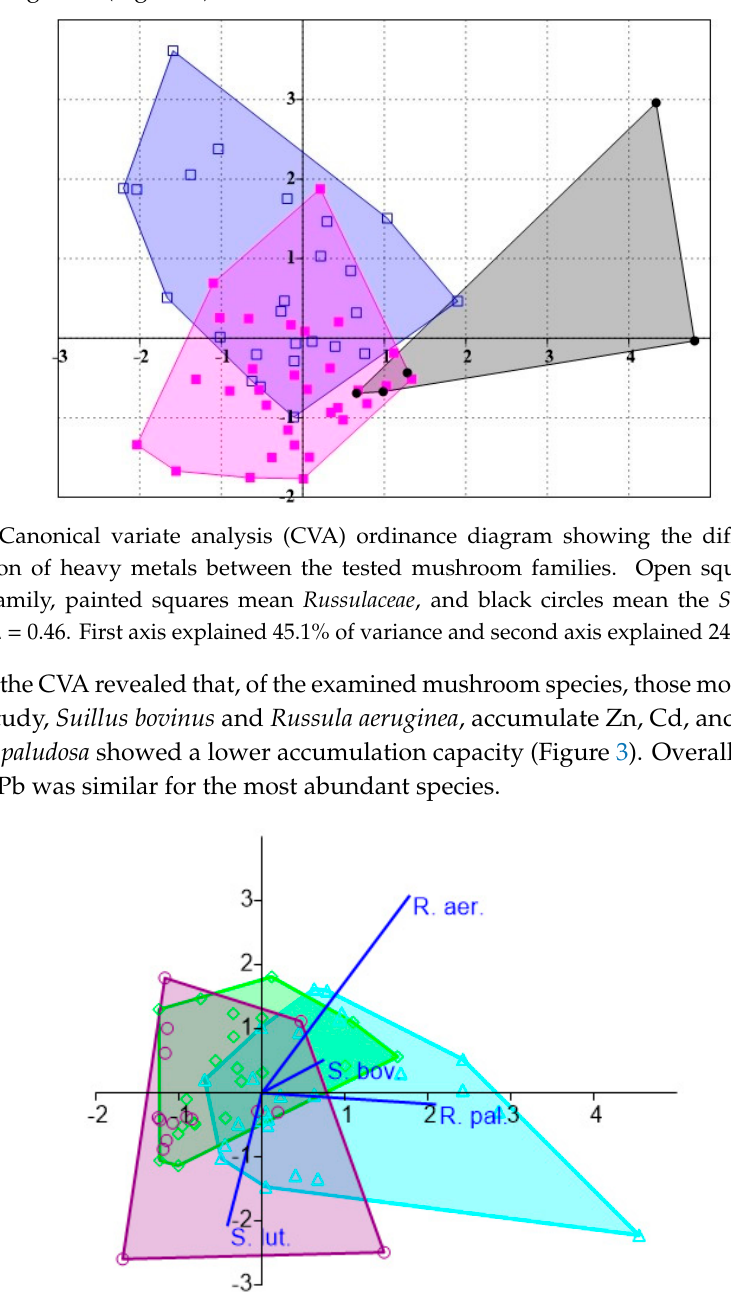
Figure 3. CVA ordinance diagram showing the differences in the accumulation of heavy metals between the most numerous mushroom species in the study area. Open circles mean Zn, diamonds indicate Cd, and triangles determine Pb. Wilk’s test λ = 0.67. Note: S. bov — Suillus bovinus , R. aer .— Russula aeruginea , R. pal. — R. paludosa , S. lut. — S. luteus .